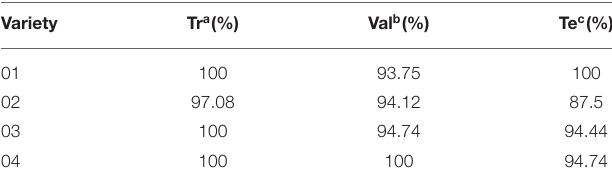
TABLE 2 | Classification results of the four varieties of